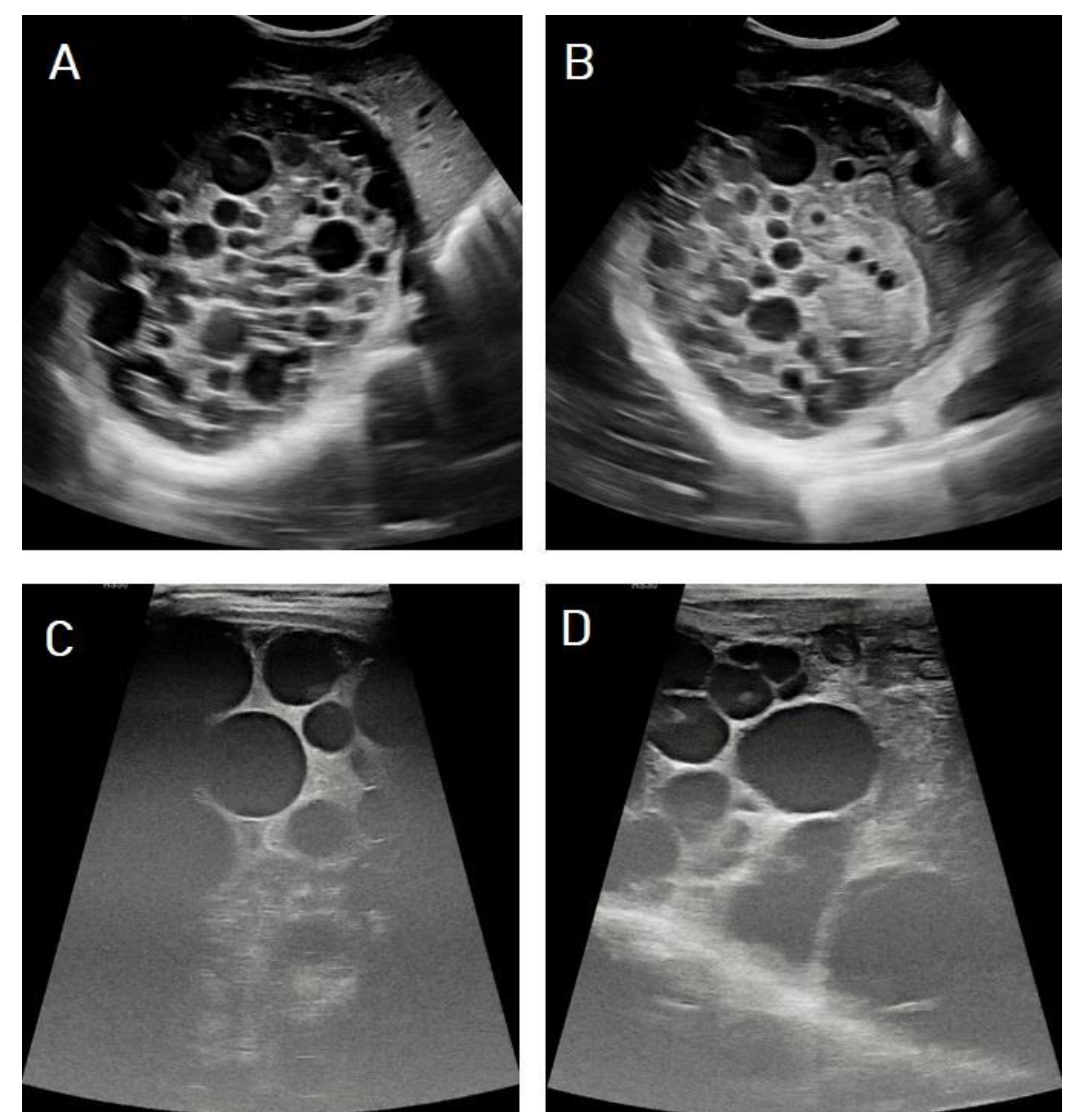
Figure 6. Ultrasound images of the liver of a 10-year-old male presenting with abdominal pain showing about 15 × 12 cm well-circumscribed, cystic lesion thin echogenic wall replacing the V, VI, and VII segments of right hepatic lobe containing multiple daughter cysts and echogenic matrices ( A , B ), which are typical images of hydatid cysts in stage CE3b (WHO classification). The daughter cysts appeared more obviously on the high-resolution images of the high-frequency linear transducer ( C , D ).